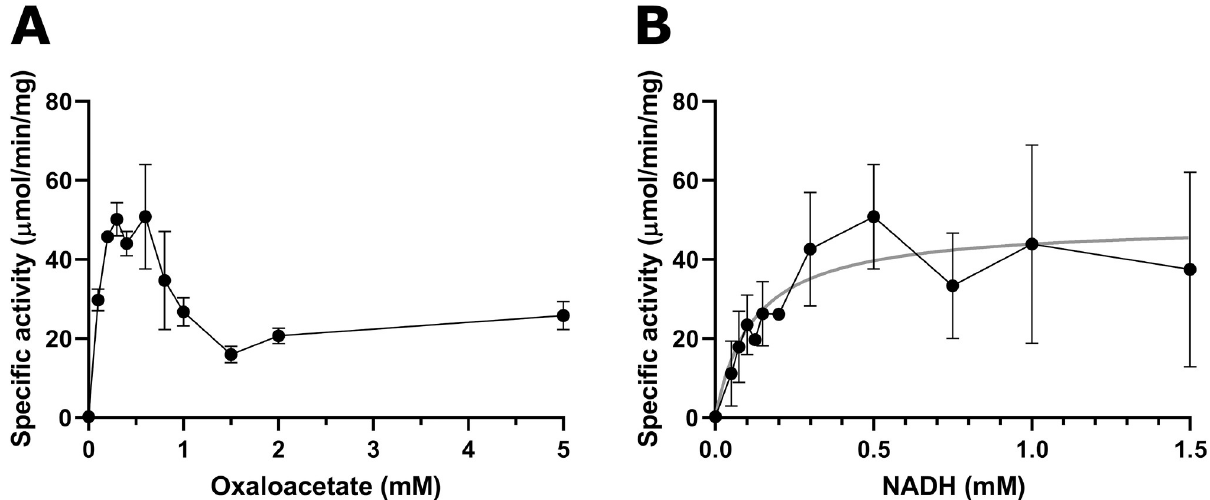
Fig 4. Michaelis-Menten plots of enzymatic activity for GST-CBU1241 in relation to substrates OAA (A) and NADH (B). Enzyme specific activity ( μ mol/mg per mg protein) measured for varying concentrations of OAA concentrations at 0.5 mM NADH (A), and varying NADH concentrations at 0.6 mM OAA (B). Error bars represent standard deviation from the mean from at least three independent experiments. Linear regression line of best fit for Michaelis-Menten kinetic equation is plotted in grey for NADH